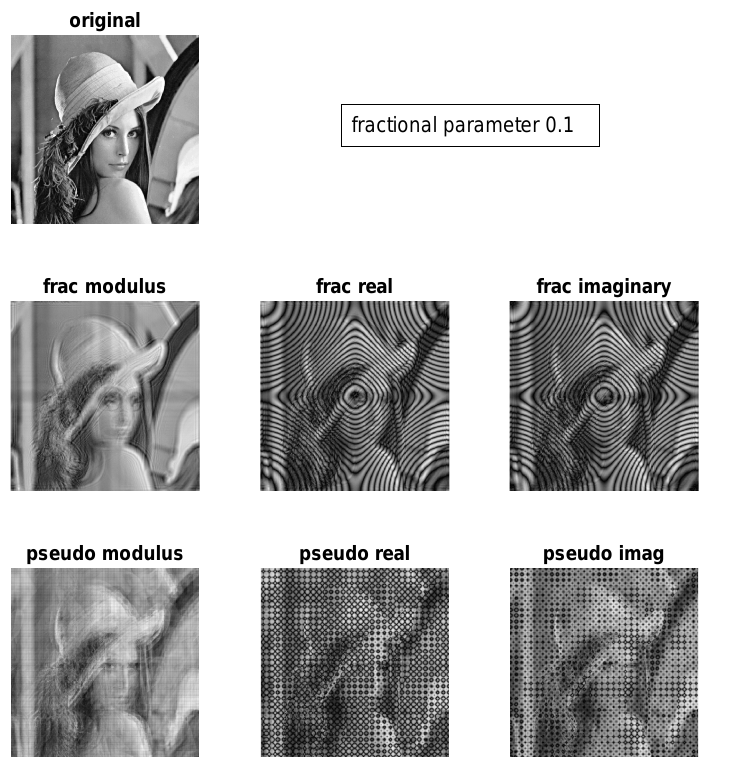
Figure 1. Comparison of DFrFT and DPFrFT of the grayscale image “Lena” for fractional parameter a = 0.1.